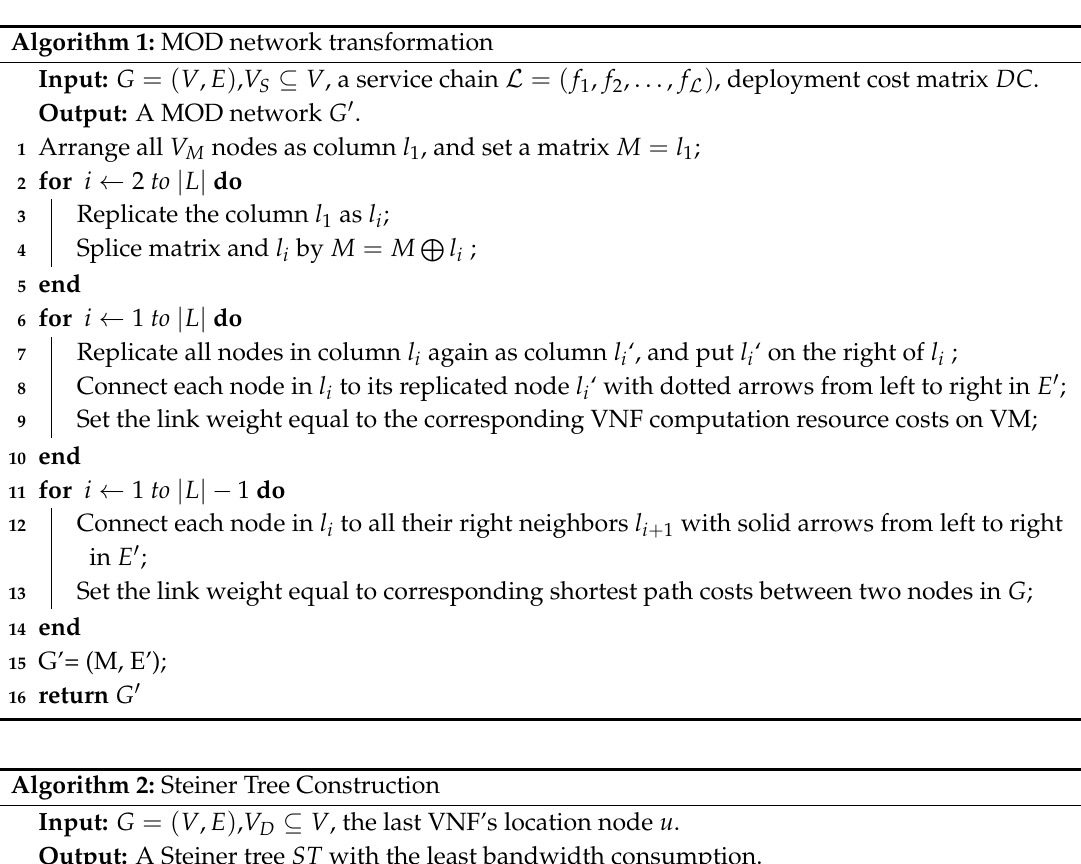
Algorithm 1: MOD network transformation